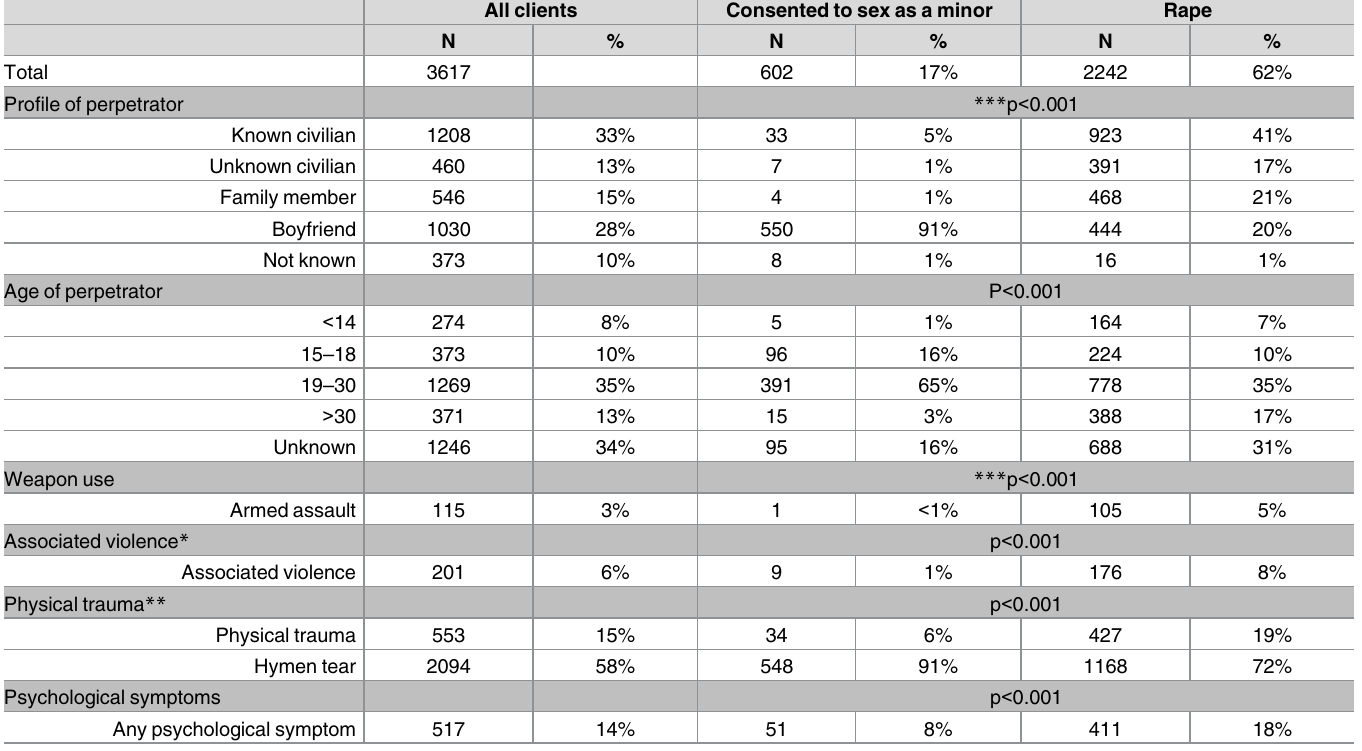
Table 1. Incident characteristics, Mbare SGBV clinic (09/2011–12/2014).